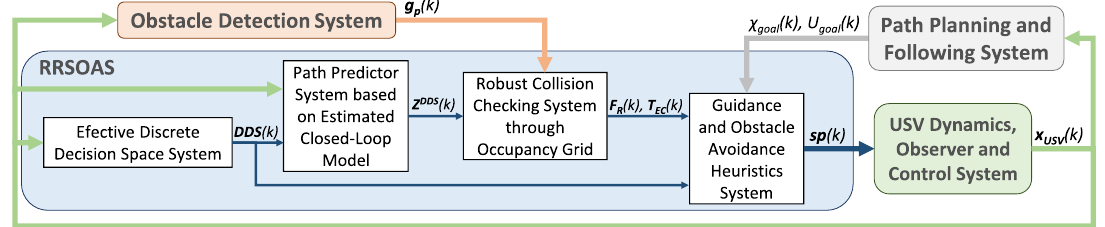
Figure 6. Functional diagram of the RRSOAS: inputs/outputs and the main